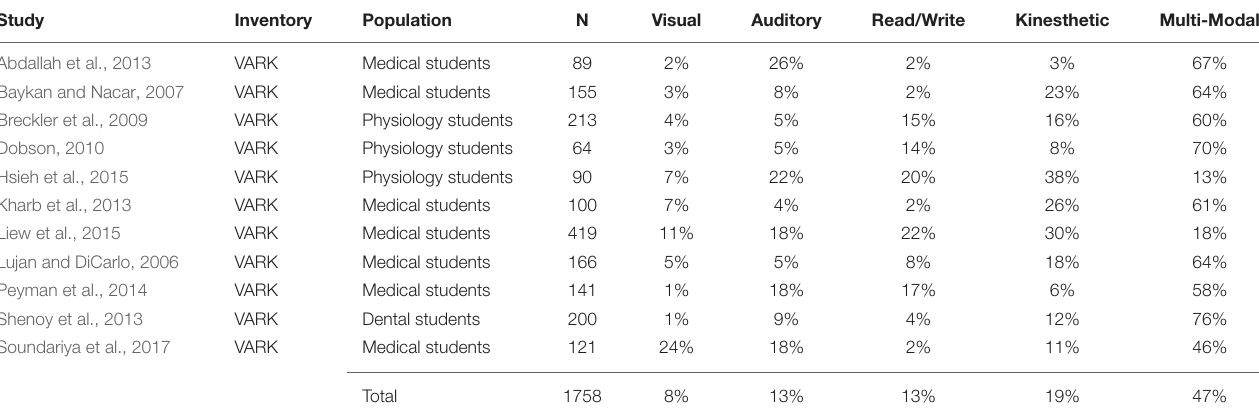
FIGURE 1 | Overview of the psychometric measurement model from modality-specific learning style theory. TABLE 1 | Prevalence of modality-specific and multi-modal learning styles across studies applying the VARK inventory in university